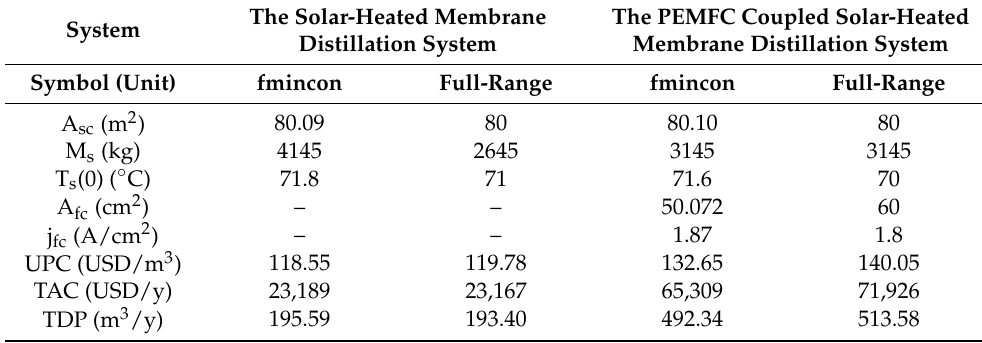
Table 9. The optimal results with different methods for both